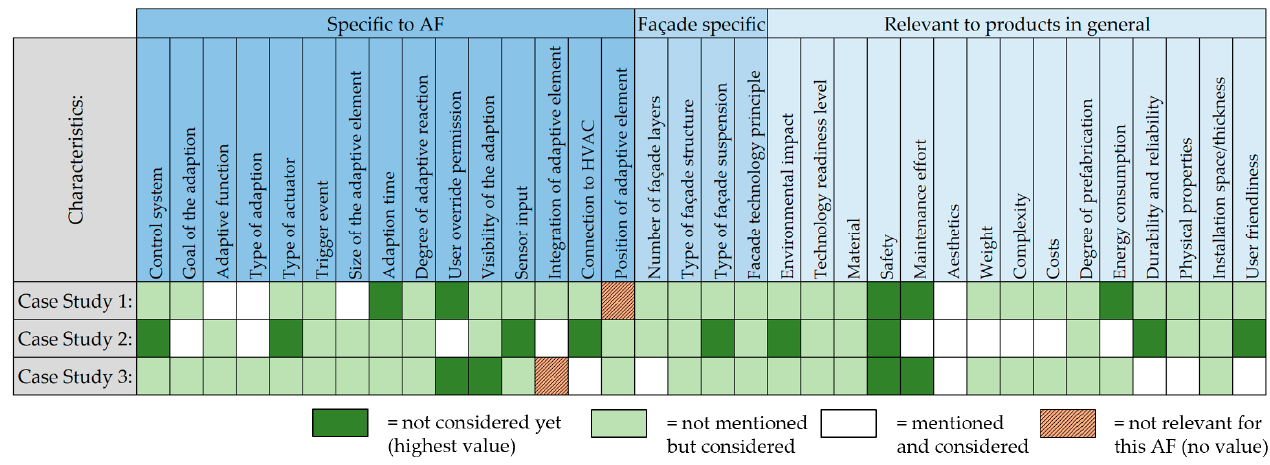
Figure 16. Evaluation results of the identi fi ed characteristics in three AF projects, adapted from [23].